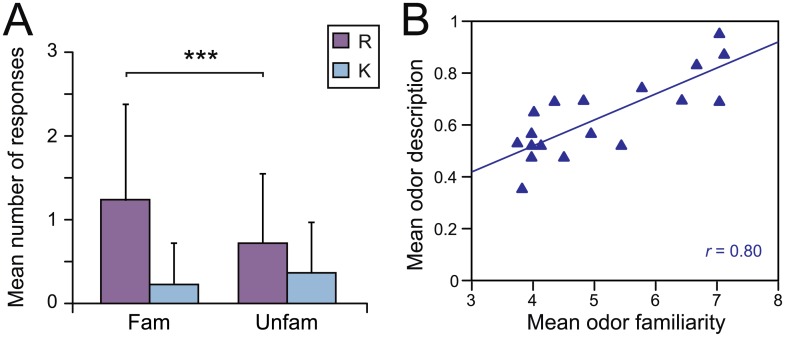
Odor familiarity and describability.A) Mean numbers of R/K responses as a function of familiarity of odors. Fam, Familiar; Unfam, Unfamiliar; Vertical bars represent the SD; ** p < 0.01, *** p < 0.001. B) Correlation between familiarity and describability of odors.